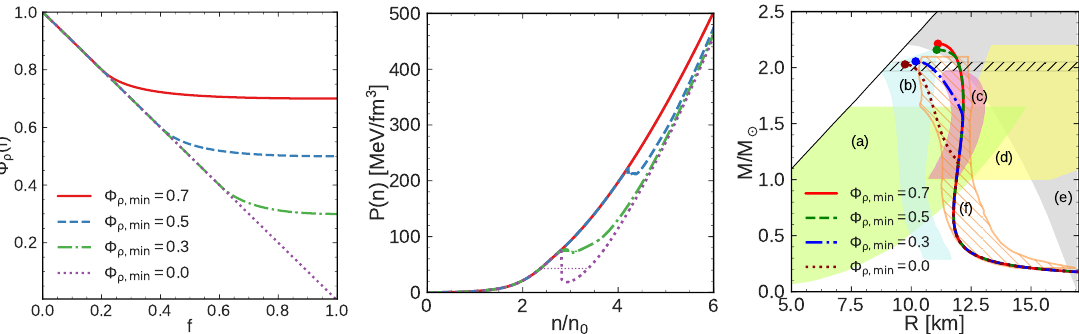
Figure 2. Left panel : the scaling function Φ ρ ( f ) as a function of the scalar field f defined by Equation (7) for Φ ρ ,min = 0,0.3,0.5,0.7. Middle panel : the pressure as a function of the baryon density for the same values of Φ ρ ,min . Right panel : mass-radius curves for the same values of the parameters. For comparison, we show the emprical constraints: (a) [14]; (b) [15]; (c) [16]; (d) [17]; (e) [18]; and (f) [19–21]. The horizontal band shows the maximum NS mass constraint within the uncertainty range